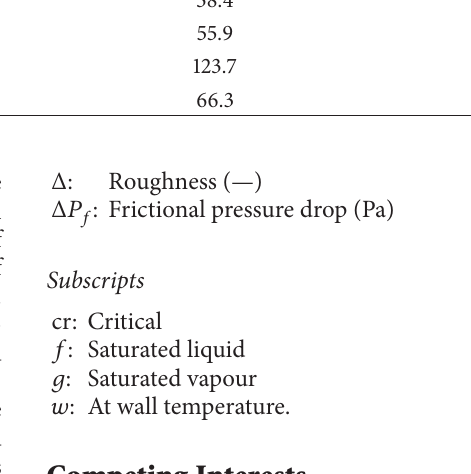
Table 4: Comparisons between STFQH and corrected RELAP5 results concerning threshold inlet throttling pressure drops. Power